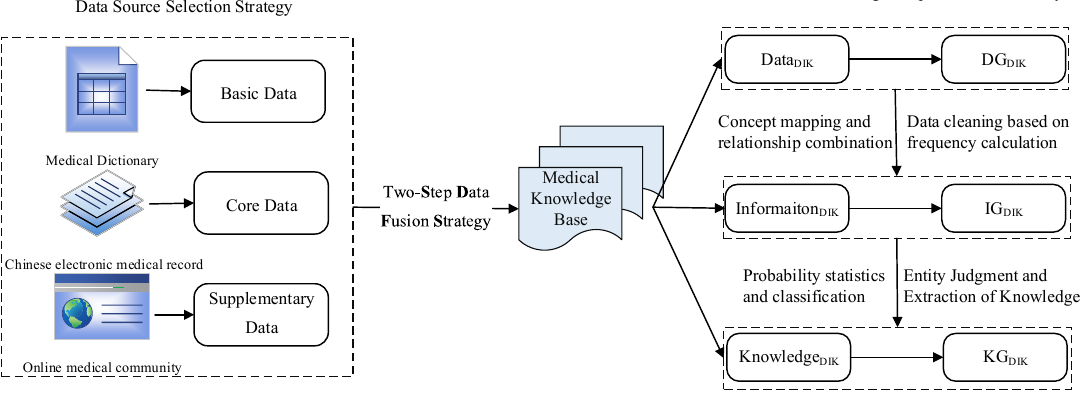
Figure 1. The construction process of a multi-data source medical knowledge graph based on the DIK